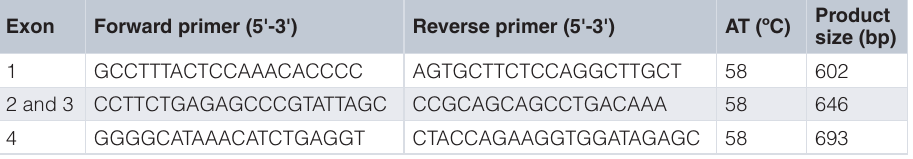
Table 2. Primers and annealing temperatures for PCR and sequencing.